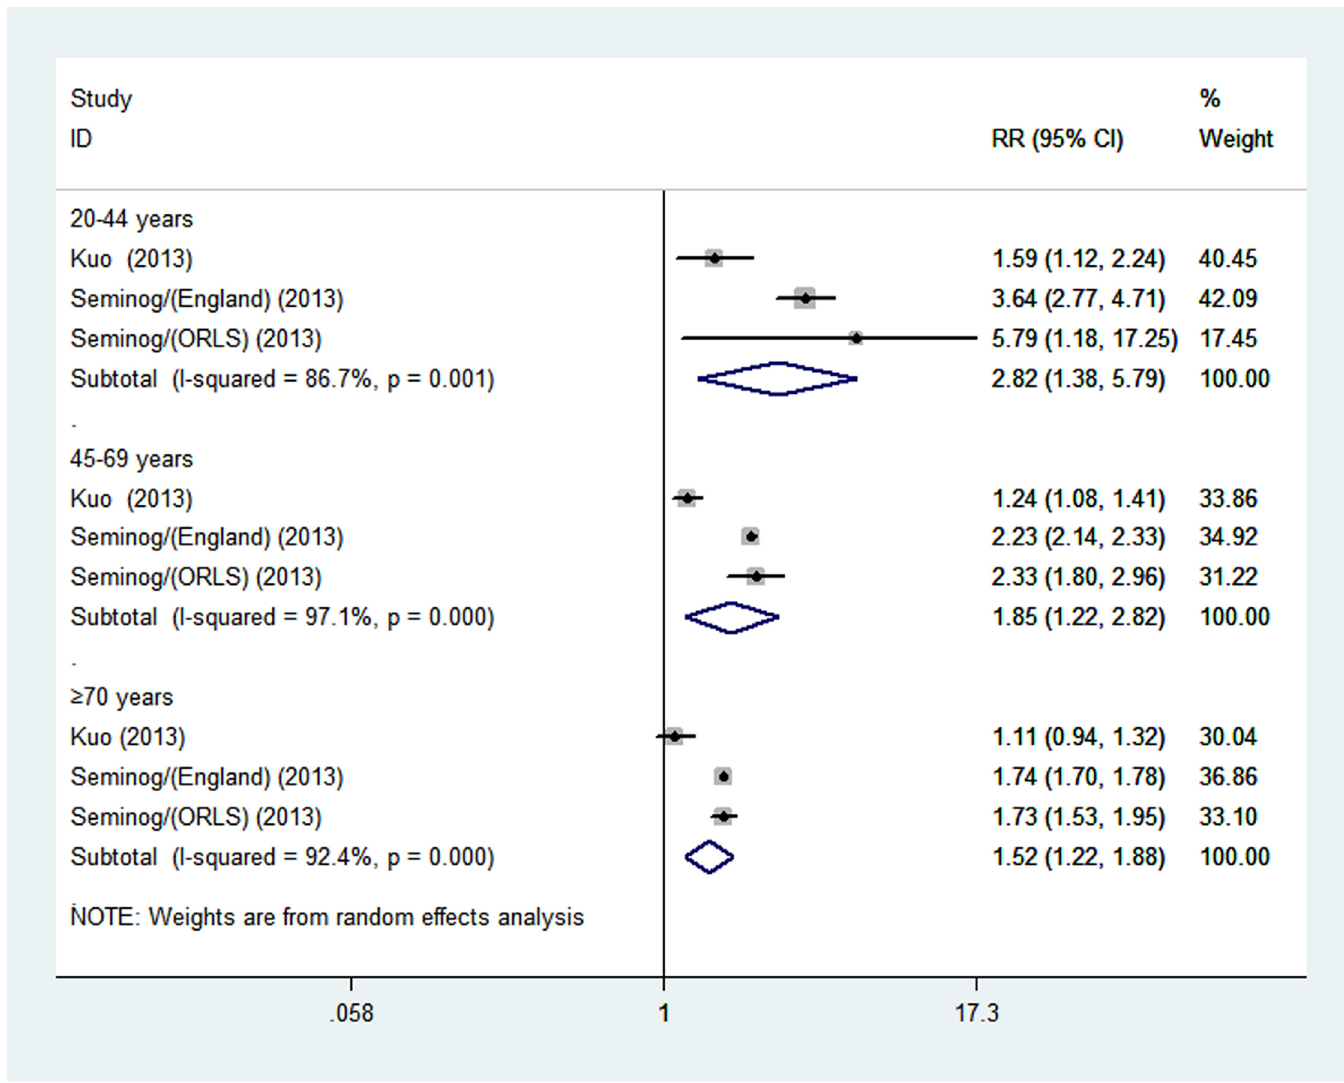
Fig 5. Meta-analysis of the association between gout and risk of myocardial infarction in age